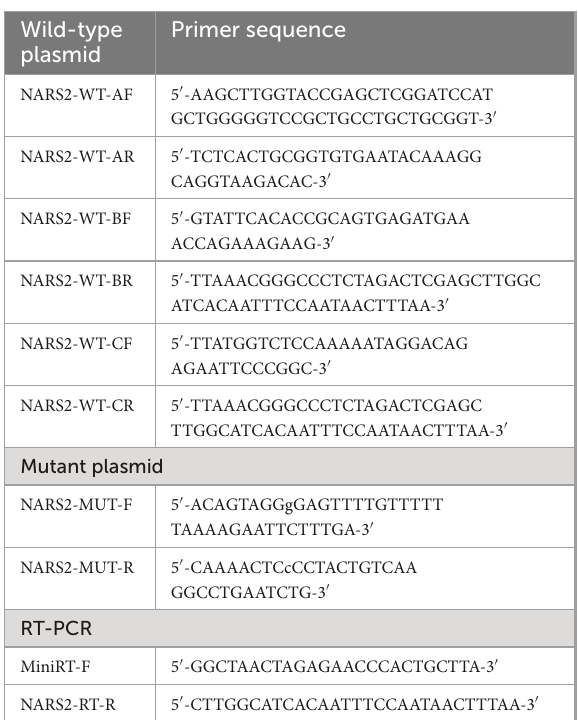
TABLE 1 Primer information in the minigene